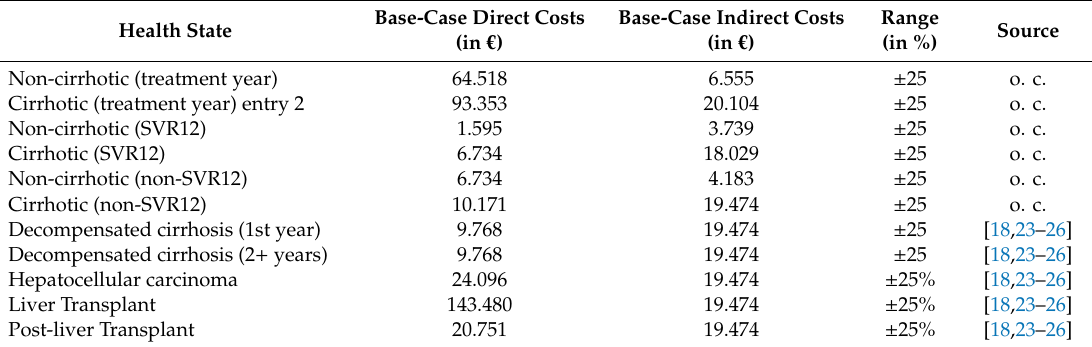
Table 1. Health state costs, in € per